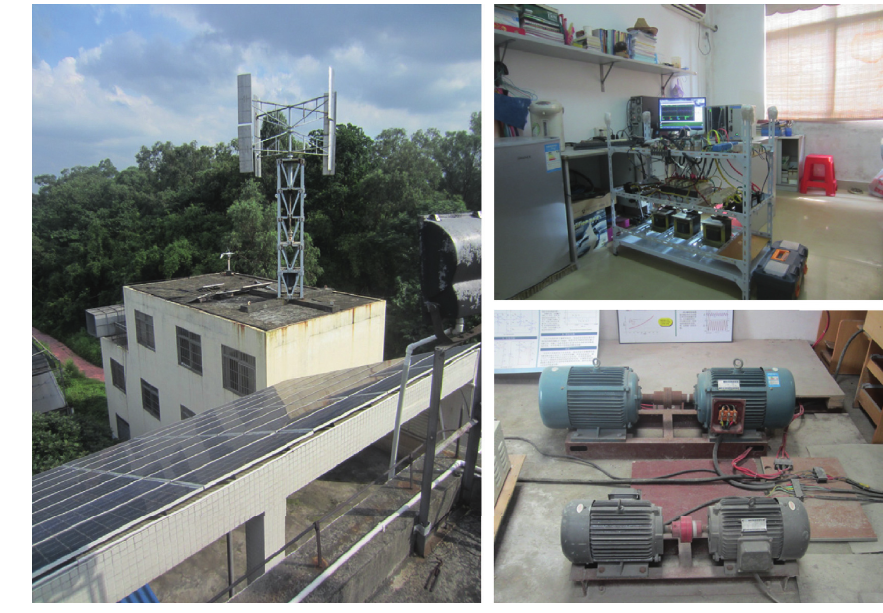
Figure 12: Experiment on microgrid system. Table 2: Specifications of the experiment.